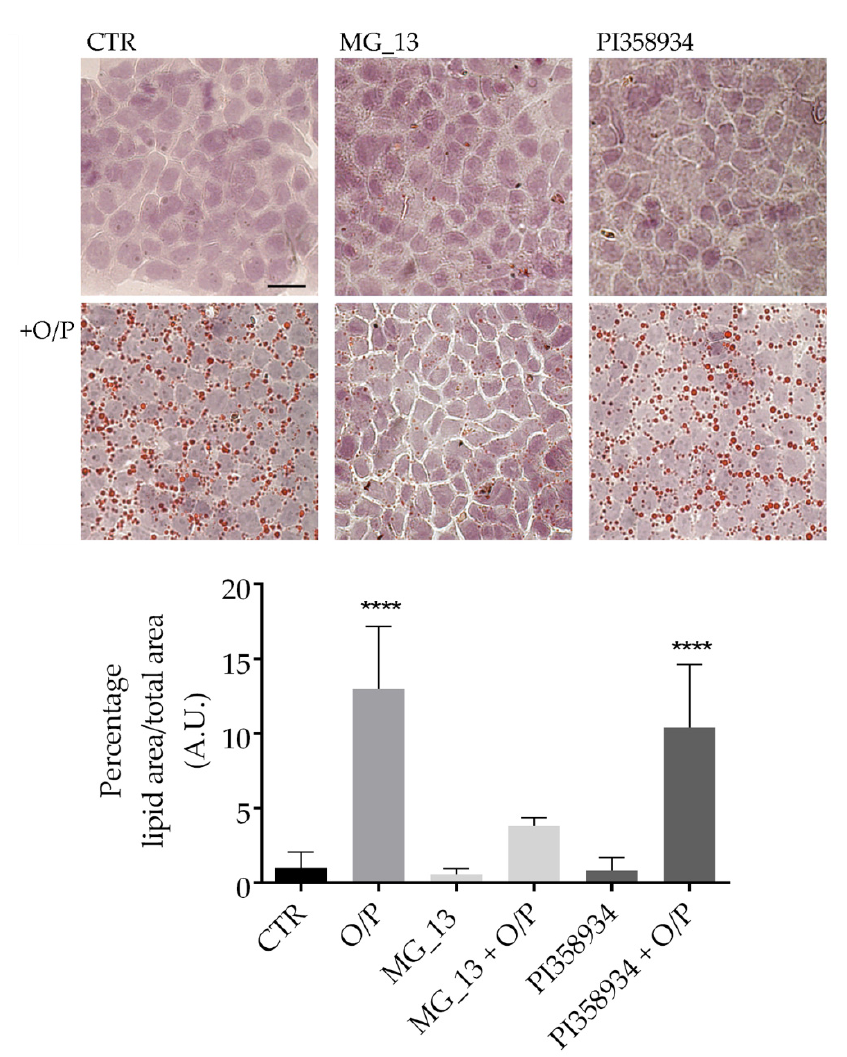
Figure 3. Detection of intracellular lipid droplets. FaO cells were left under basal condition (CTR) or treated with MG_13 (0.1 mg / mL), PI358934 (0.1 mg / mL) or with chickpea extract in the presence of a mixture of free fatty acids (FFAs) (oleate / palmitate). Oil Red O staining revealed lipid droplet formation. Lipid droplets are stained dark red and were analyzed using Image-J software (Bar 25 µ m). Data are shown as a percentage of lipid area / total area and are presented as means ± S.D. of 3 independent experiments and analyzed by one-way ANOVA followed by Dunnett’s multiple comparisons test. (**** p < 0.0001 vs. CTR).